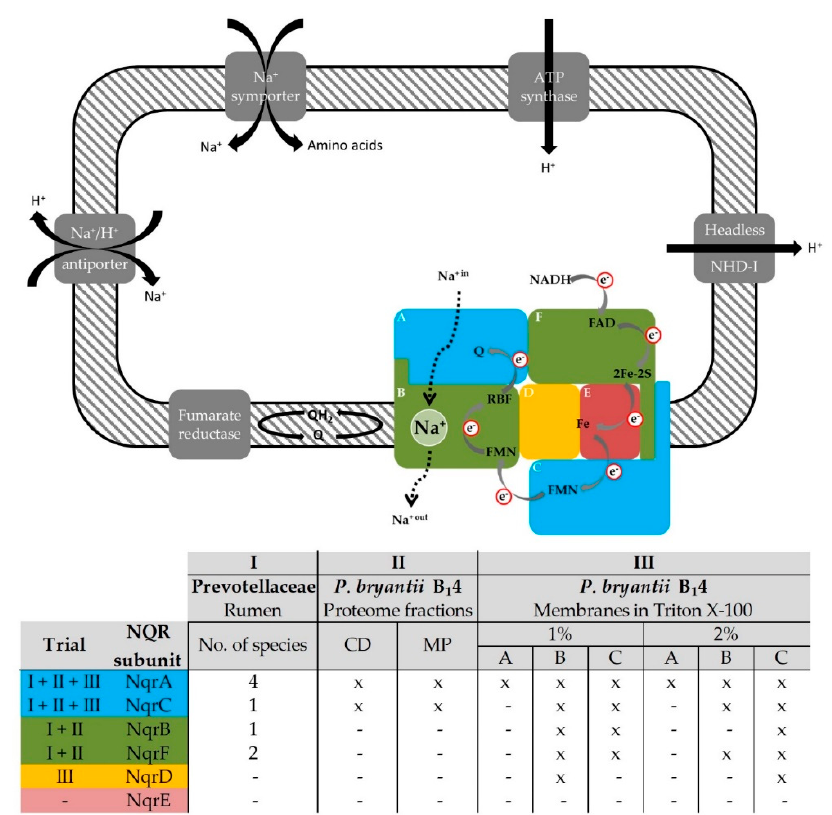
Figure 6. Critical role of the NQR in energy conservation of members of the Prevotellaceae family. Upper panel: The NQR consists of the six subunits NqrABCDEF and catalyzes the oxidation of NADH and reduction of quinone (Q) under translocation of Na + (broken arrow). This overall reaction requires FAD and a 2Fe-2S protein in subunit NqrF, an iron (Fe) site in subunits NqrDE, one FMN in each subunit NqrC and NqrB, a riboflavin and a presumed Na + binding site in NqrB, and a quinone (Q) binding site in NqrA. Electron (e − ) transfer steps are indicated by grey arrows. Fumarate may constitute the final electron acceptor receiving electrons from quinol. The sodium motive force generated by the NQR may be used for sodium-symporters or the establishment of a proton gradient via Na + / H + antiporters or the headless NDH-I complex to drive ATP regeneration. Lower panel: Nqr subunits identified in the rumen or in P. bryantii B 1 4 by mass spectrometry in three experimental trials (I, II, III) indicated by color